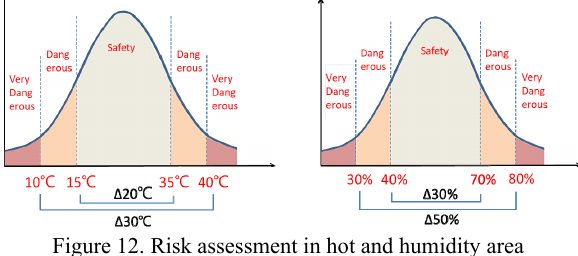
Figure 12. Risk assessment in hot and humidity